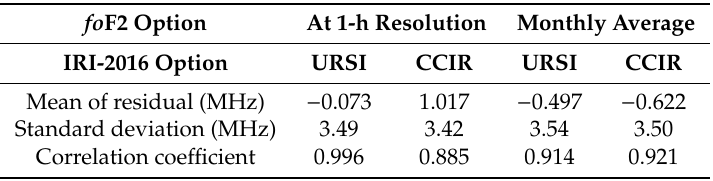
Table 1. The standard deviation and correlation coe ffi cient computed.